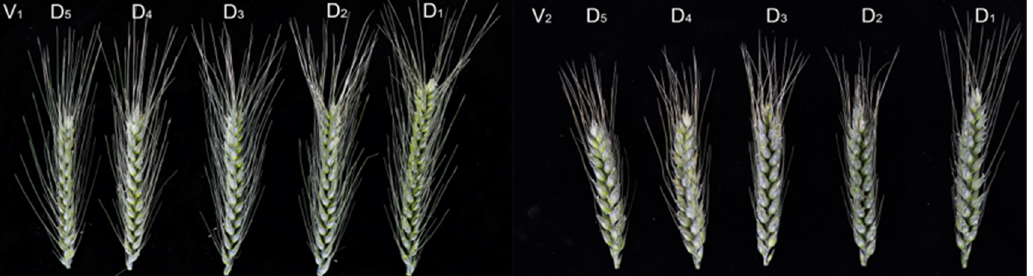
Figure 8. Effects of planting density on the spikes of uniformly sown winter wheat. V 1 , Xindong 50. V 2 , Sangtamu 4. D 1 –D 5 refer to 123 × 10 4 , 156 × 10 4 , 204 × 10 4 , 278 × 10 4 , and 400 × 10 4 plants·ha − 1 planting densities, respectively. Table 3. Effects of planting density on yield and yield components in uniformly sown winter